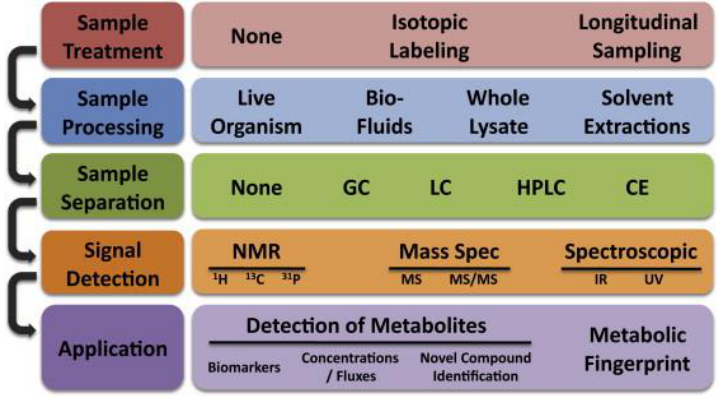
Figure 6. The typical workflow for single cell metabolomics analysis. Multiple experimental steps are involved in the metabolomics study, each one with different possible methodologies. Reprinted with permission from [128], Copyright (2010) Elsevier